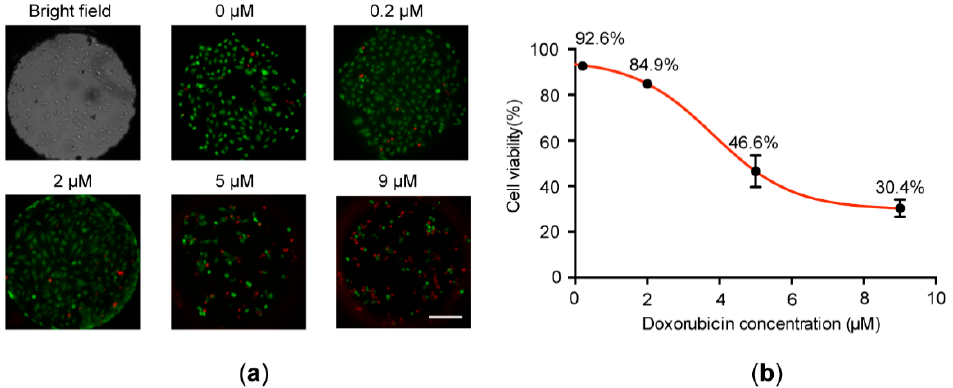
Figure 8. Doxorubicin-induced cell apoptosis on the chip. ( a ) Fluorescent micrographs of MCF-7 cells treated with different concentrations of doxorubicin and stained with calcein AM and PI (scale bar: 200 μ m). ( b ) Calibration curve of cell viability vs. doxorubicin concentrations (n = 7).